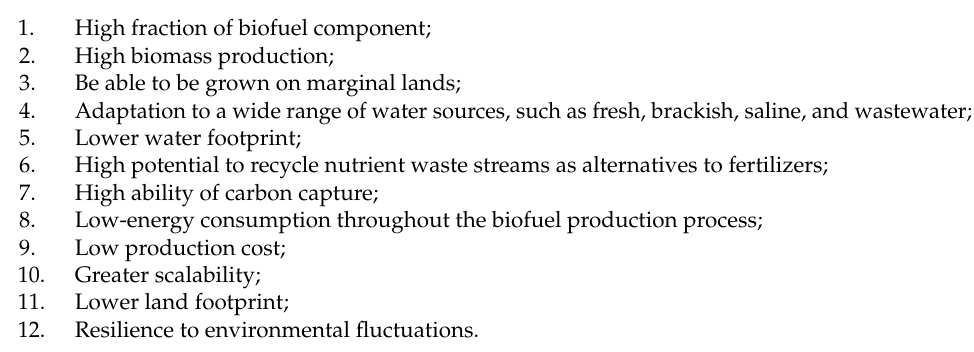
Table 1. Requirement for an ideal organism as an alternative feedstock to fossil fuels (prepared in reference of